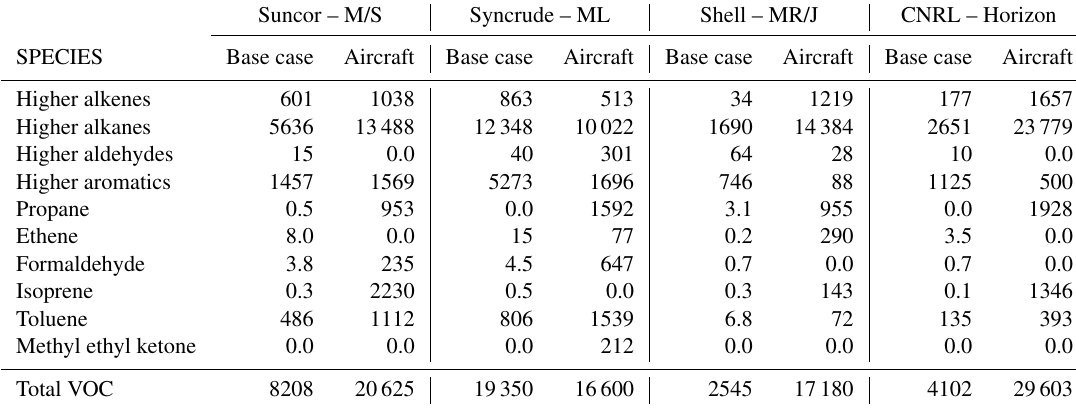
Table 4. Comparison of speciated annual ADOM-2 (Acid Deposition and Oxidant Model, version 2) model VOC species emissions (tyr − 1 ) between base-case emissions from the 2013 NPRI version 2 (bottom-up) and the aircraft-observation-based estimates (top-down). Note that unknown or unreactive VOC species are not included. Suncor Millenium and Steepbank: Suncor – M/S; Syncrude Mildred Lake: Syncrude – ML; Shell Muskeg River and Jackpine: Shell –